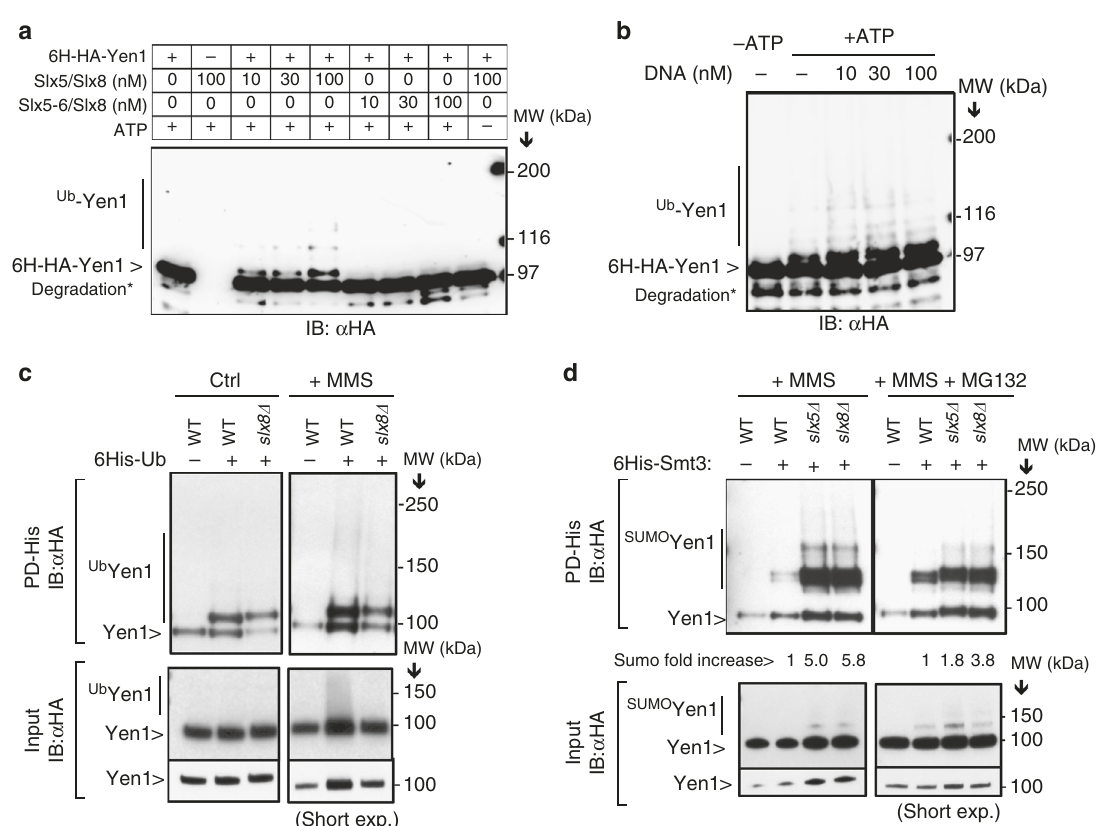
Fig. 3 Yen1 is a direct substrate of the Slx5 – Slx8 ubiquitin ligase. a H6-HA-Yen1 (916 nM) was ubiquitinated in vitro in the presence of the indicated concentrations of either Slx5/Slx8 or the RING mutant Slx5 – 6/Slx8 and 0.2 µ M DNA. Control lanes with H6-HA-Yen1 in the absence of E3 and Slx5/8 in the absence of Yen1 are shown. Breakdown products of Yen1 are marked with an asterisk. b The ubiquitination reaction was performed as above but with 50 nM Slx5 – Slx8 and increasing amounts of DNA. c Strains expressing 6xHis-Ub were subjected to different growth conditions and lysed to pull-down ubiquitinated proteins under denaturing conditions, input Yen1-HA levels were controlled to allow comparisons. d Smt3 denaturing pull-downs were performed in wild type, slx5 Δ , or slx8 Δ cells (all in a pdr5 Δ background) after growth in the presence of MMS. The fold increase in the sumoylated fraction indicated at the bottom of the gel is an average of three trials. Inputs were controlled in each trial to allow comparison of the eluted sumoylated